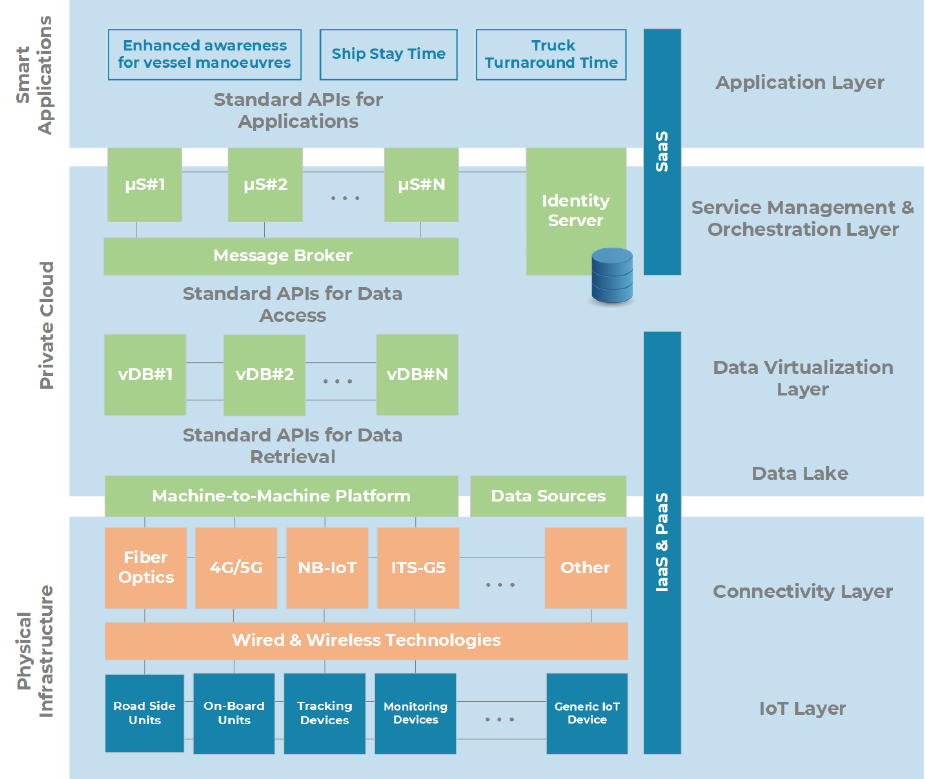
Figure 1. Livorno Port ICT Reference Architecture